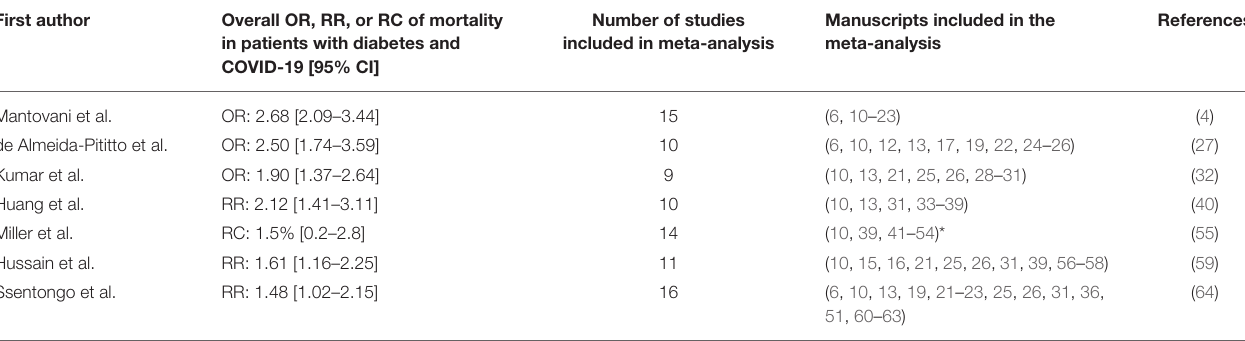
TABLE 1 | Meta-analyses of the mortality risk associated with pre-existing diabetes in COVID-19